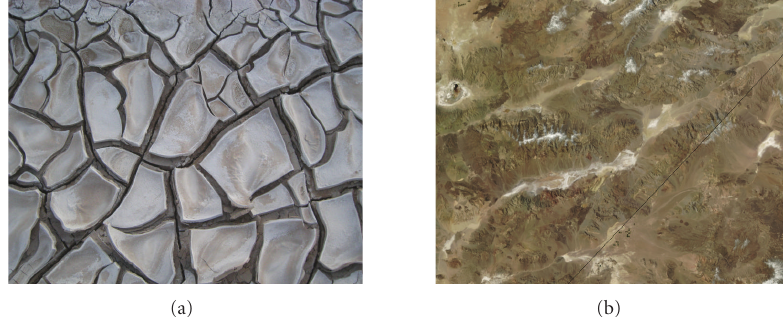
Figure 2: Images of Death Valley: (a) “cracked mud on the way to the borax haystacks,” by redteam , Creative Commons license, (b) a satellite image from NASA (public domain). On this example, there is no self-similarity between the two scales of this region.